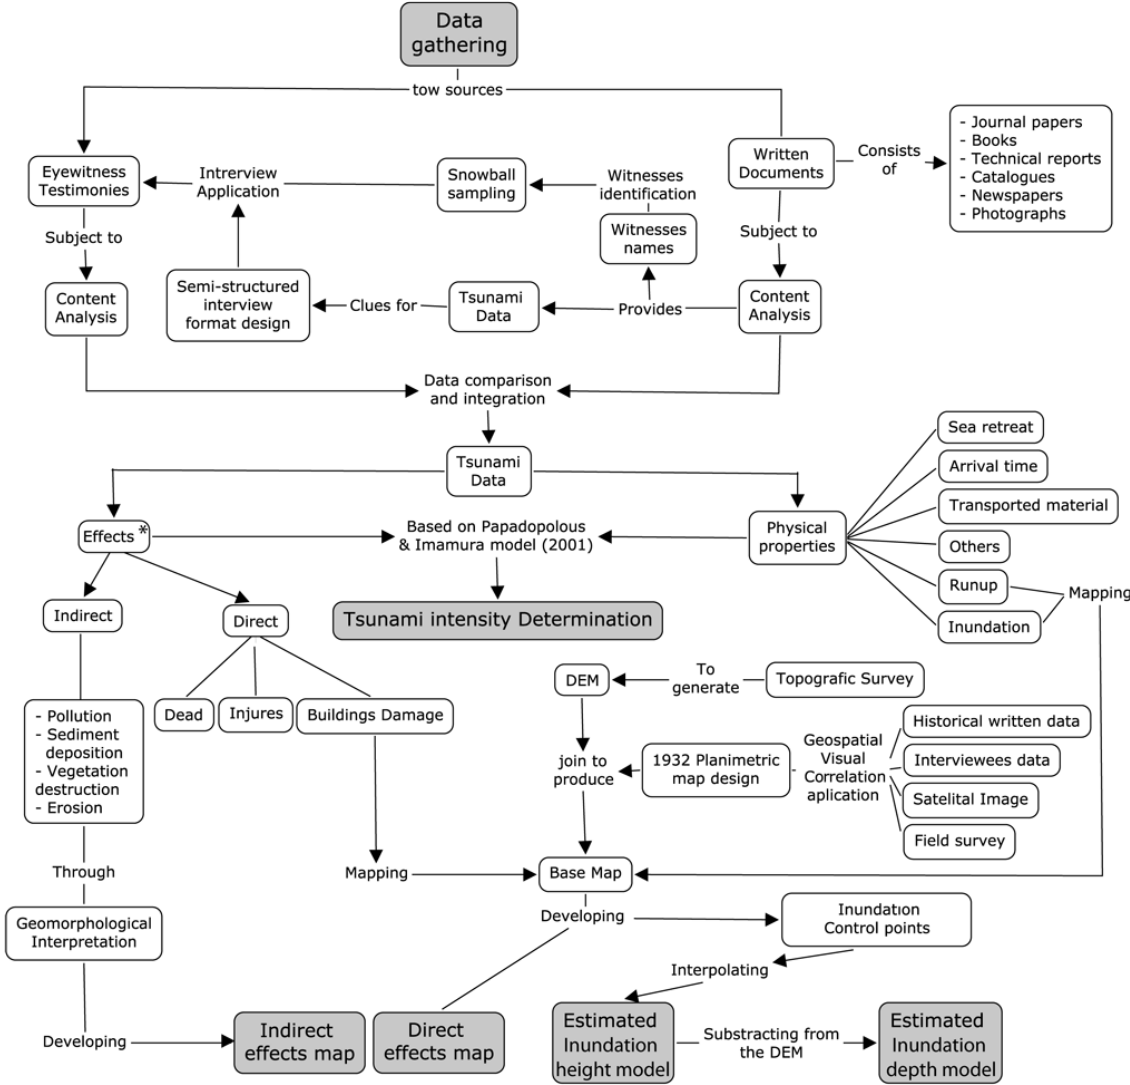
Fig. 3. Flow methodology chart. *Note: the tsunami effects were classified according to the scheme proposed by UNESCO-IOC (2006). Table 2. Characteristics of a VIII intensity tsunami according to Papadopolous and Imamura